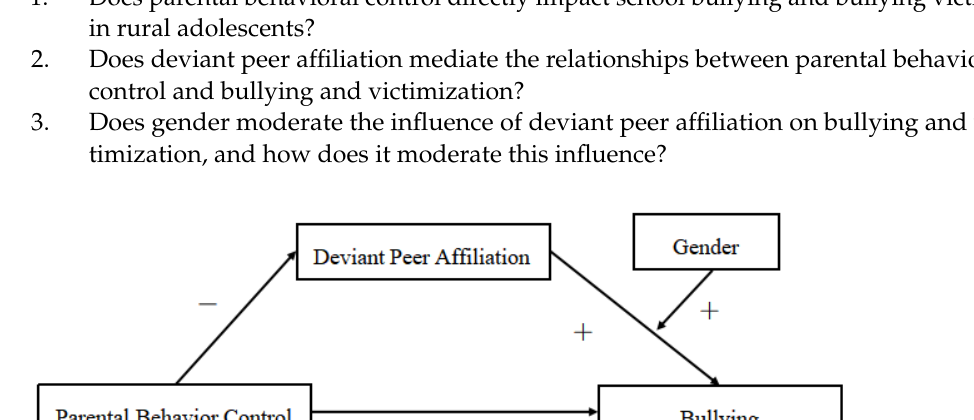
Figure 1. The proposed moderated mediation model for bullying.